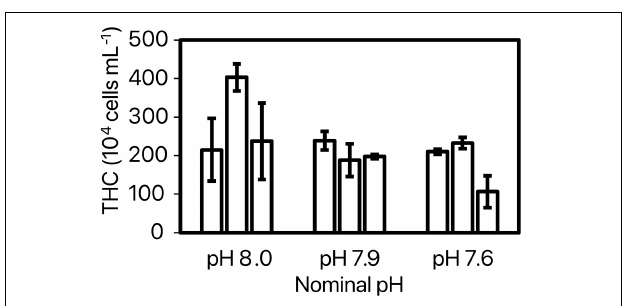
FIGURE 4 | Total hemocyte counts (THC, 10 4 cells mL − 1 ) for each replicate of tested nominal pH NIST